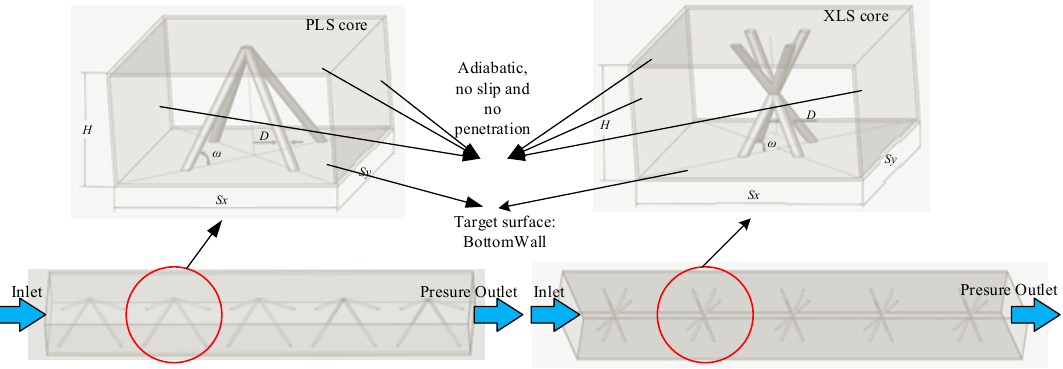
Figure 2. PLS and XLS used in internal cooling channels of blade.